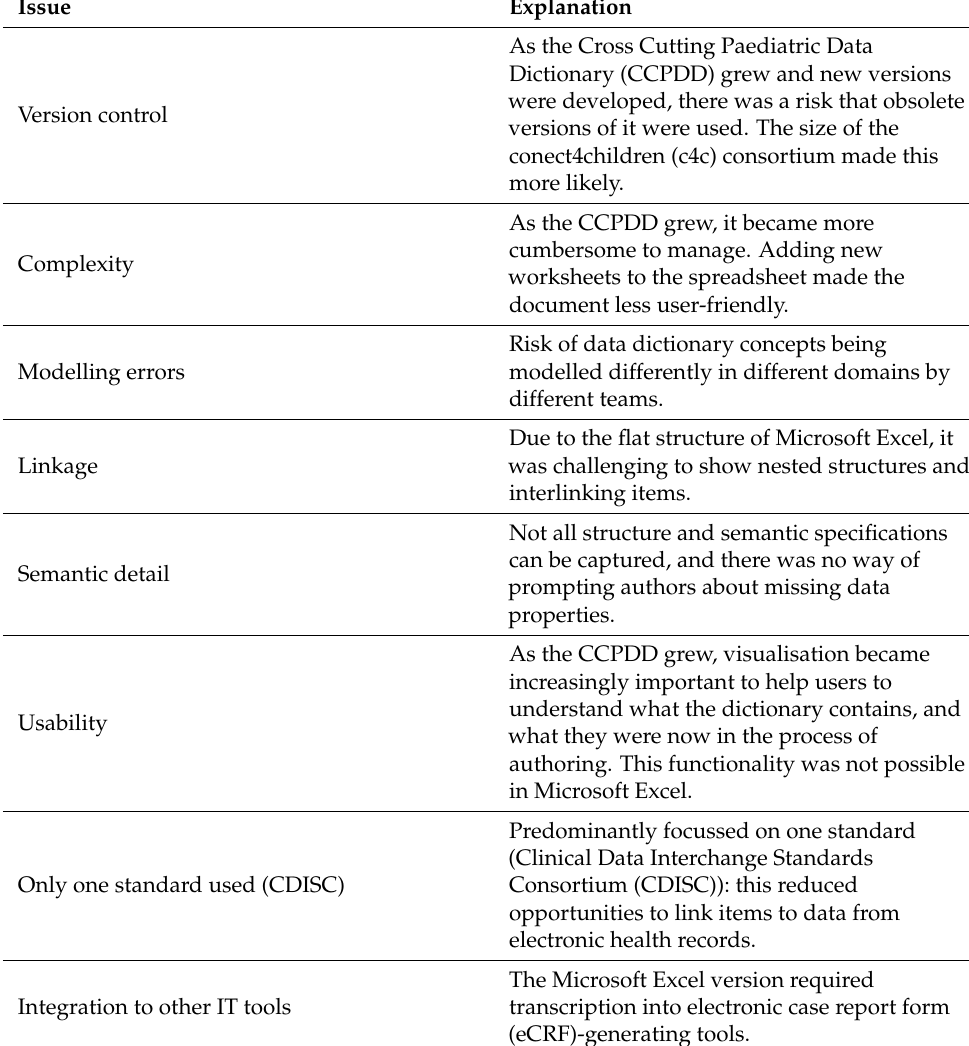
Table 1. Challenges of using a Microsoft Excel spreadsheet to represent the